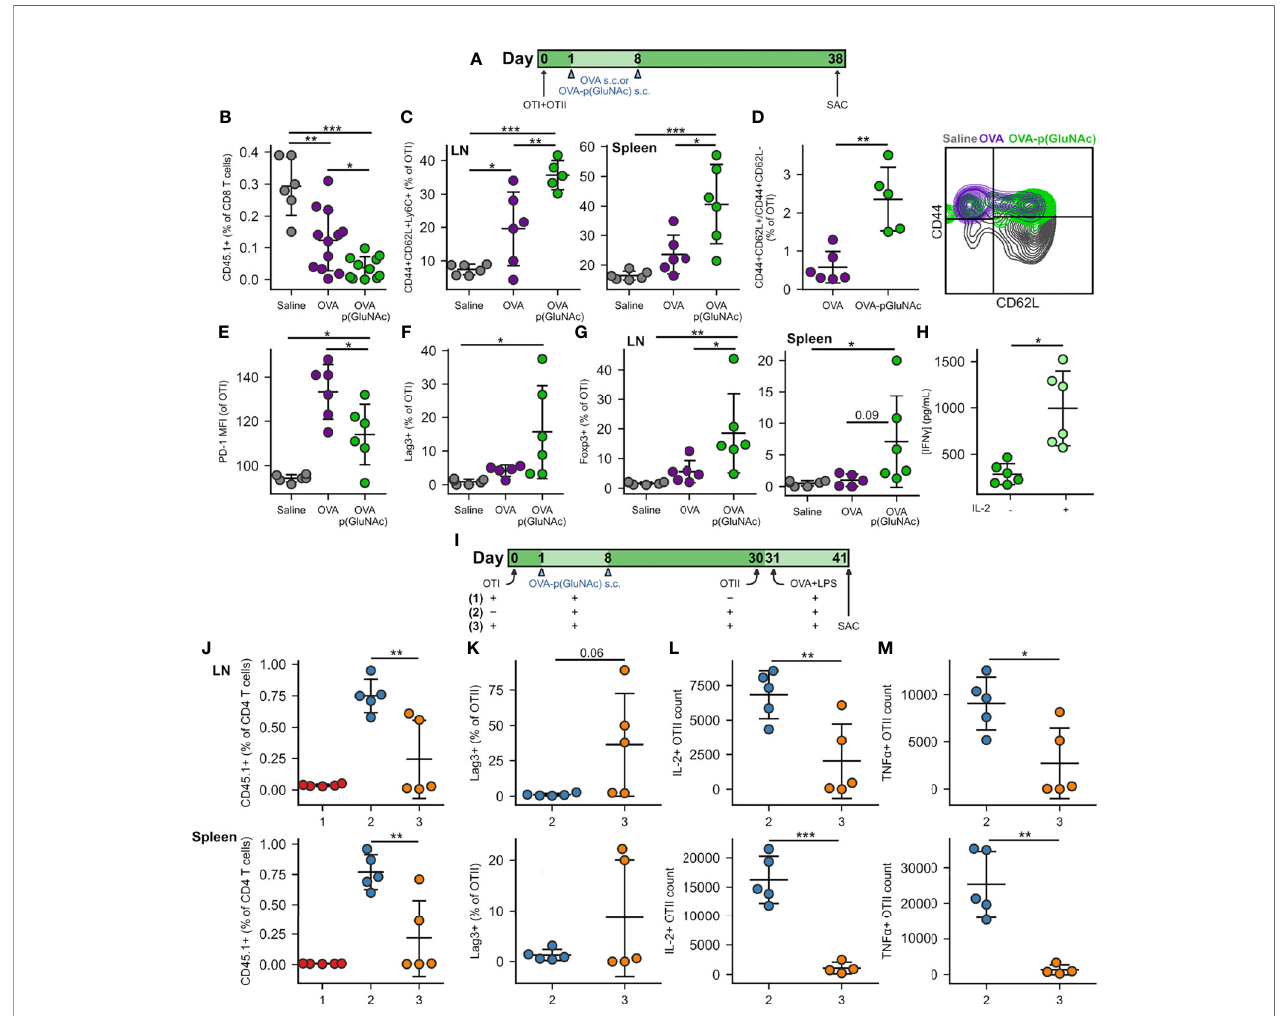
FIGURE 3 | (A) CD45.2 + mice that had received an adoptive transfer of 1x10 6 of both OTI (CD45.1 + CD3 + CD8 + ) and OTII (CD45.1 + CD3 + CD4 + ) T cells via i.v. injection, were treated s.c. in all four hocks on days 1 and 8 with saline, or 20 m g of OVA or OVA-p(GluNAc) (5 m g per hock). On day 38, all mice were sacri fi ced and the dLNs and spleen were analyzed for OTI and OTII T cell phenotype. (B) OTI CD8 + T cells recovered from dLNs. (C) Central memory OTI CD8 + T cells in dLNs (left) and spleen (right). (D) Ratio of central memory to effector memory OTI CD8 + T cells (left) and representative fl ow cytometry contour plot of the memory subsets (right) induced in the spleen. (E) PD-1 MFI on OTI CD8 + T cells in dLNs. (F) Lag-3 + OTI CD8 + T cells in dLNs. (G) Foxp3 + OTI CD8 + T cells in dLNs (left) and spleen (right). (H) Splenocytes from the OVA-p(GluNAc) group were restimulated with 100 m g/mL OVA in culture media alone or supplemented with 200 Units/mL (~12 ng/mL) exogenous IL-2, and IFN g levels were measured in the supernatant 3 days later by ELISA. (I) CD45.2 + mice received a fi rst adoptive transfer of 1x10 6 OTI CD8 + T cells (groups 1,3) or no cells (group 2), followed by two s.c. OVA-p(GluNAc) treatments on days 1 and 8 for all groups. On day 30, mice from groups 2 and 3 received a second adoptive transfer of 5x10 5 OTII CD4 + T cells. All mice were administered an OVA+LPS challenge on day 31, and 10 days later, the dLNs and spleen were examined for the OTII CD4 + T cell response. (J) OTII CD4 + T cells recovered from dLNs (top) and spleen (bottom). (K) Lag-3 + OTII CD4 + T cells in dLNs (top) and spleen (bottom). (L) Numbers of IL-2 producing OTII cells in dLNs (top) or spleen (bottom) after a 6-h ex vivo restimulation with OVA 323-339 peptide. (M) Numbers of TNF a secreting OTII CD4 + T cells in dLNs (top) or spleen (bottom) after a 6-h ex vivo restimulation with OVA 323-339 peptide. Data are pooled from two independent experiments (n= 5-12), and represent the mean ± SD. *p ≤ 0.05, **p ≤ 0.01, ***p ≤ 0.001 by one-way ANOVA using Tukey ’ s post hoc test in (B, C, E – G, J) , and unpaired Student ’ s T test in (D, H, K – M)